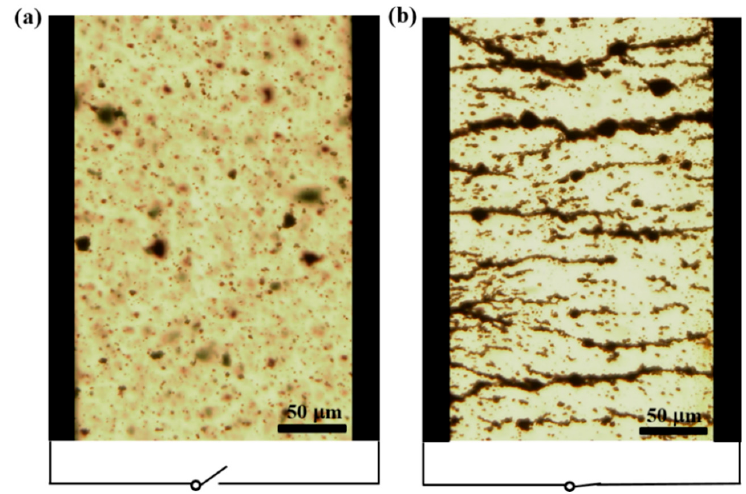
Figure 3. Optical microscopy ( OM) images of PDPA/Fe 3 O 4 particles suspended in silicone oil without ( a ), and with ( b ) the electric field (0.75 kV/mm).